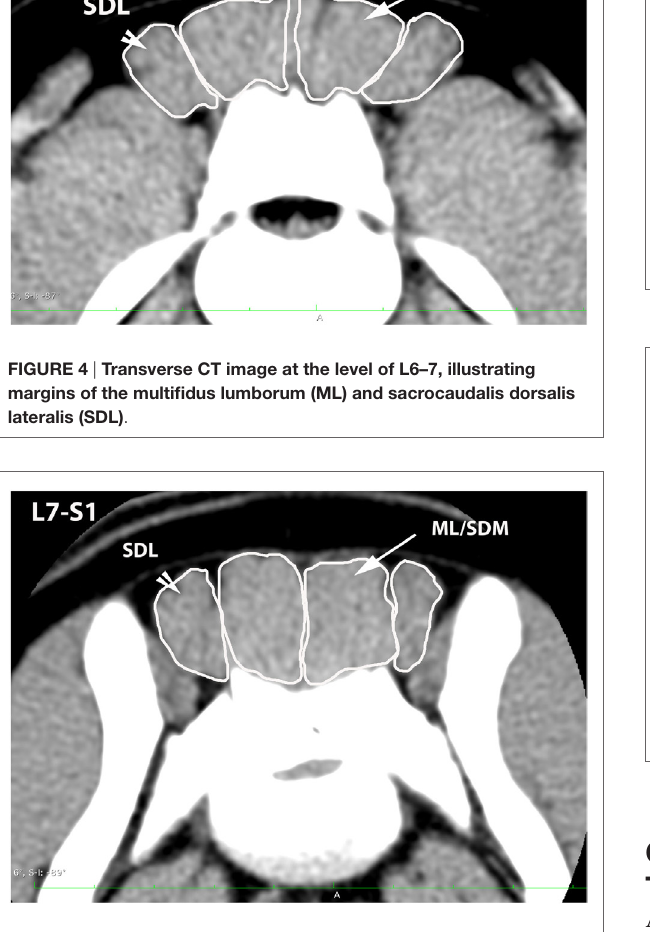
FIGURe 5 | transverse Ct image at the level of L7–s1, illustrating margins of the sacrocaudalis dorsalis lateralis (sdL) and the combined multifidus lumborum/sacrocaudalis dorsalis medialis (ML/sdM) .